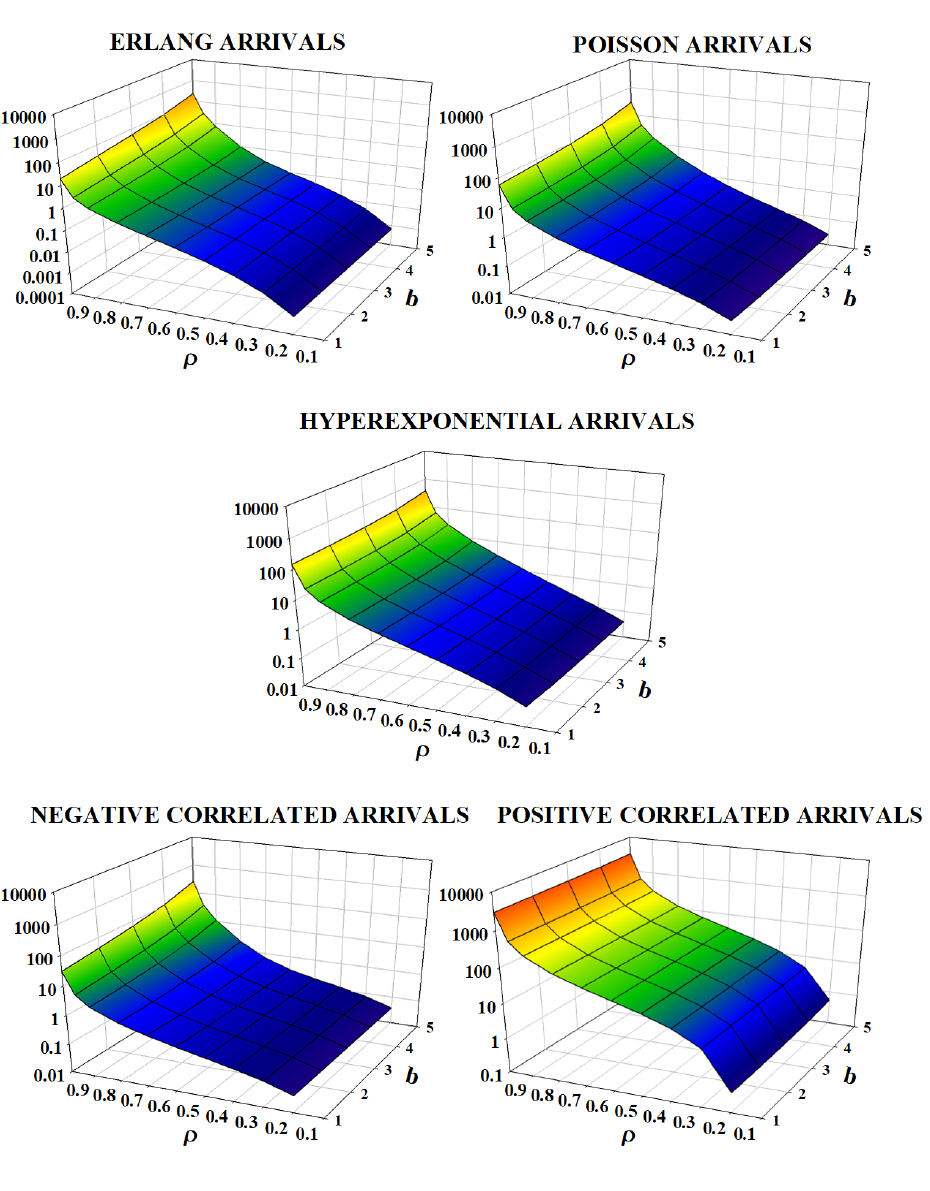
Figure 2. Mean number in queue ( µ N